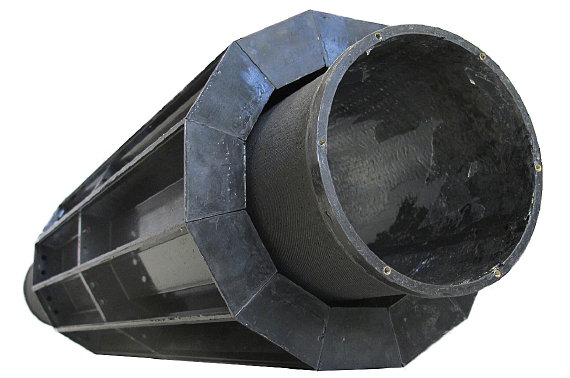
Figure 3. Carbon fiber structure with inner cylinder and 12